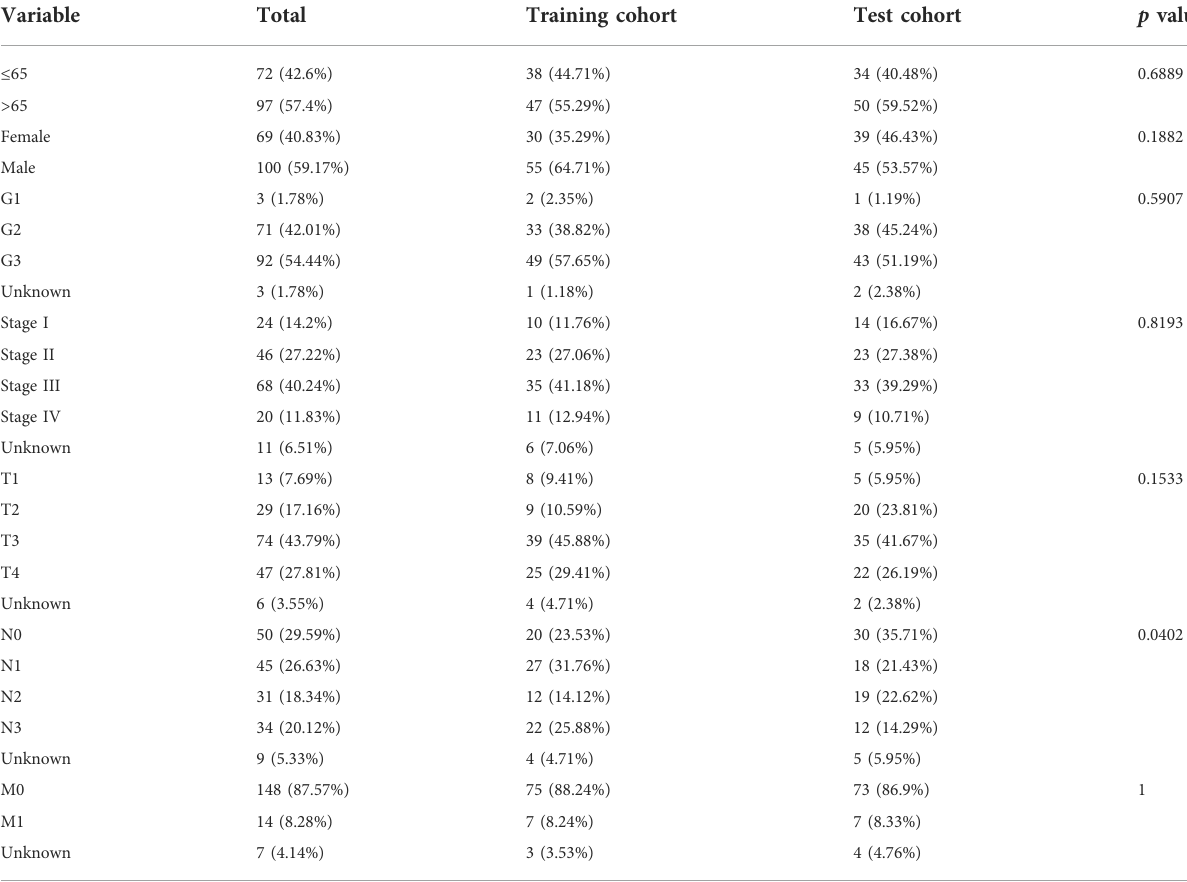
TABLE 1 Clinicopathologic and demographic characteristics of STAD patients in the training and test